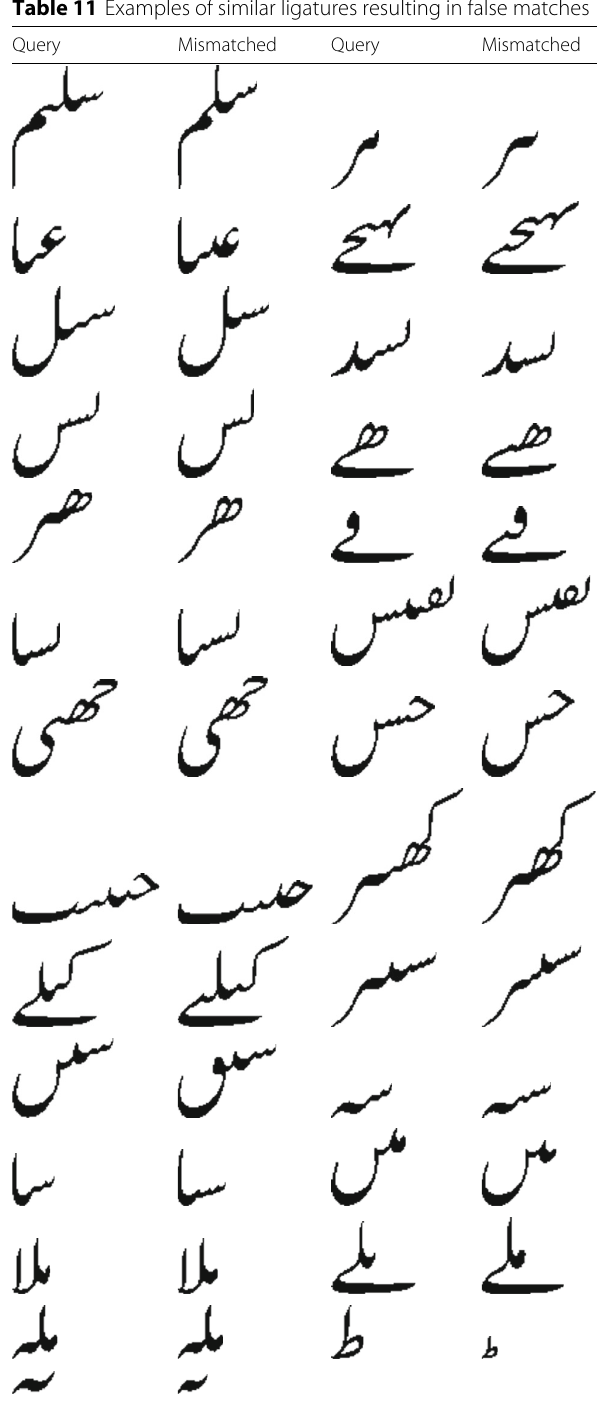
Table 11 Examples of similar ligatures resulting in false